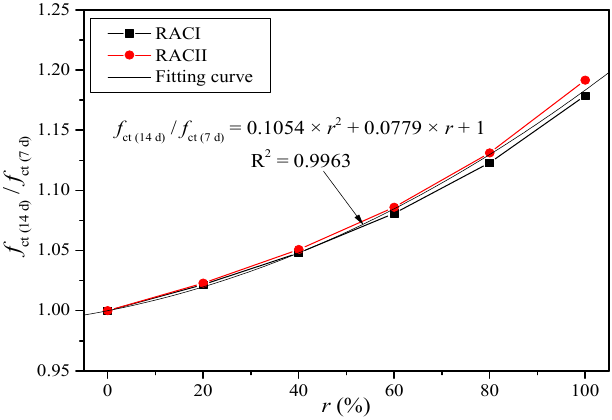
ffi cient γ 14d